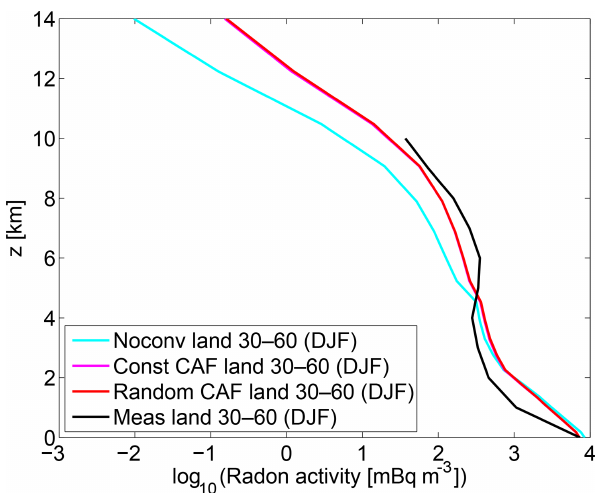
Figure 15. Observed mean radon profile obtained from measure- ments over land (30 ◦ N–60 ◦ N, December–February) by Liu et al. (1984) compared to the simulated radon obtained from 15-year long-time runs for the same region and months.